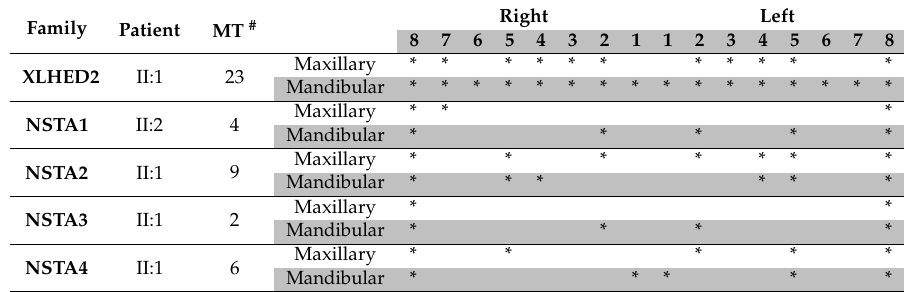
Table 2. Summary of missing permanent teeth of the five probands whose panoramic radiographs are available.